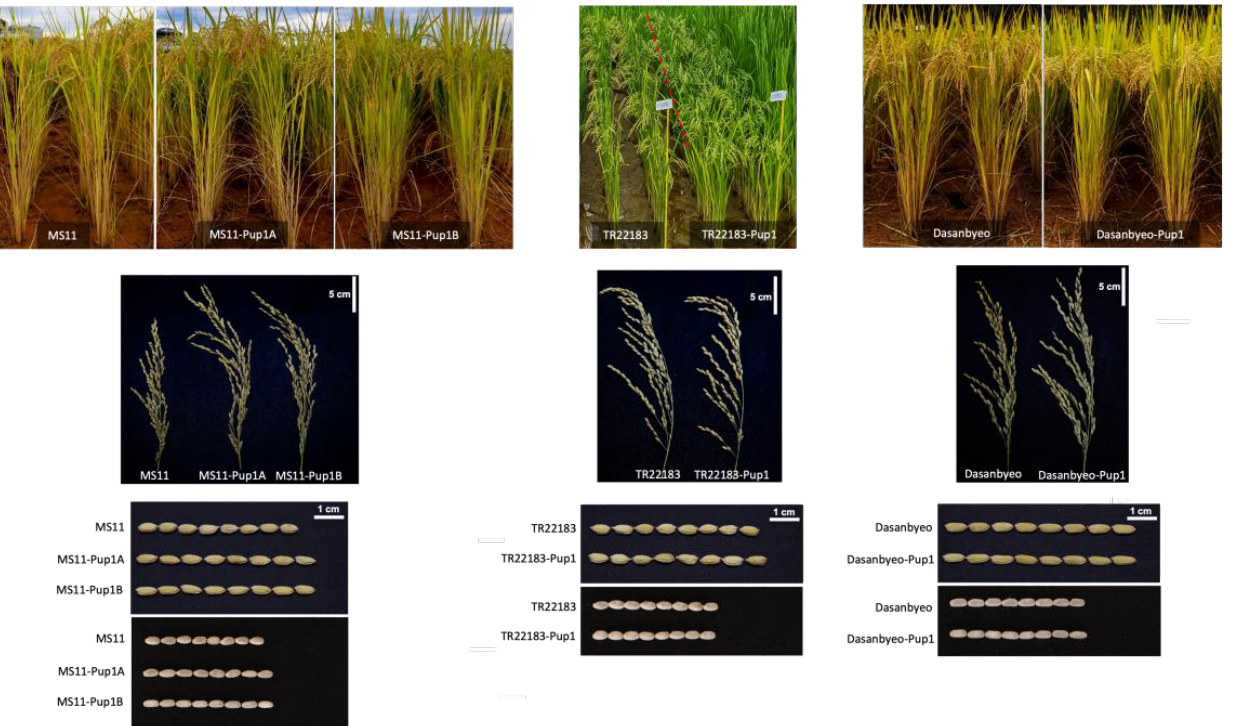
Figure 6. Plant shape, panicle, and grain characteristics of the temperate Pup1 introgression lines grown in low P and water input (Hwaseong, 2022).